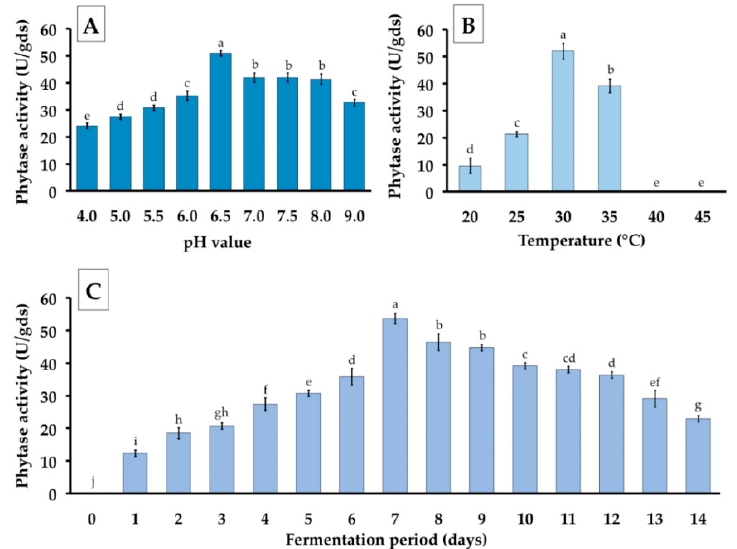
Figure 5. Phytase activity from P. adiposa in SSF under different ( A ) initial pH of basal liquid medium, ( B ) temperature for incubation, and ( C ) fermentation periods. The results are means ± SD. Different letters above each bar in the same parameter indicate the significant difference ( p < 0.05).